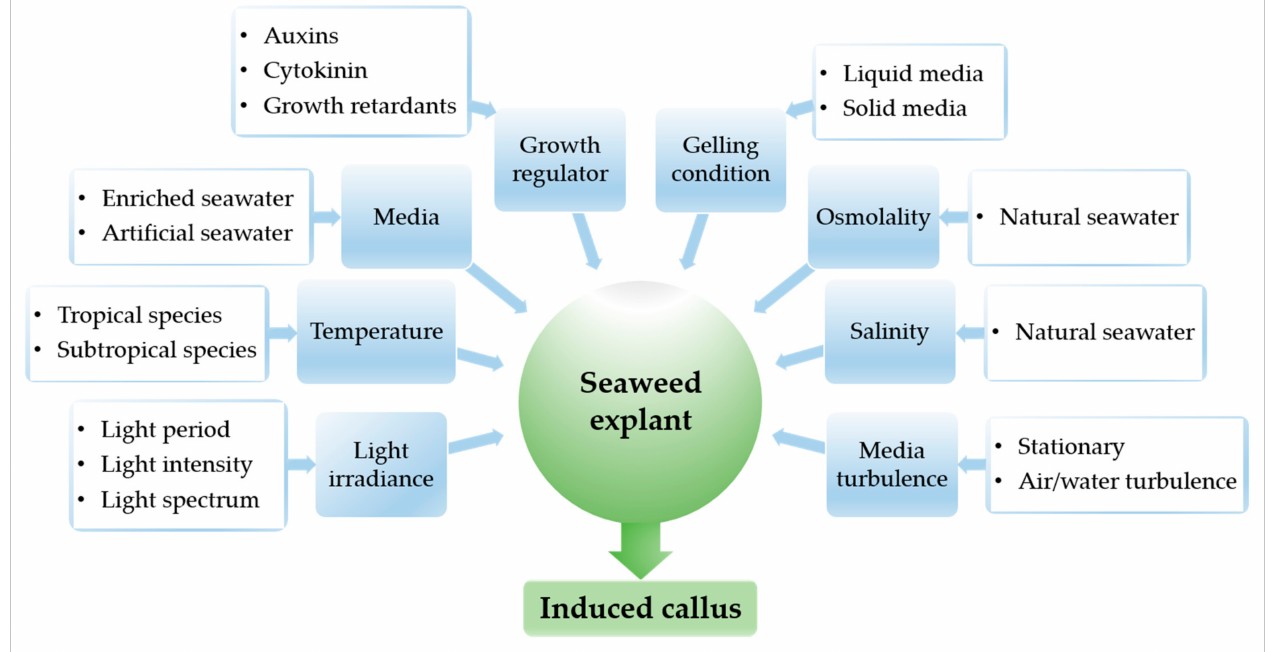
Figure 4. Abiotic factors of seaweed callus